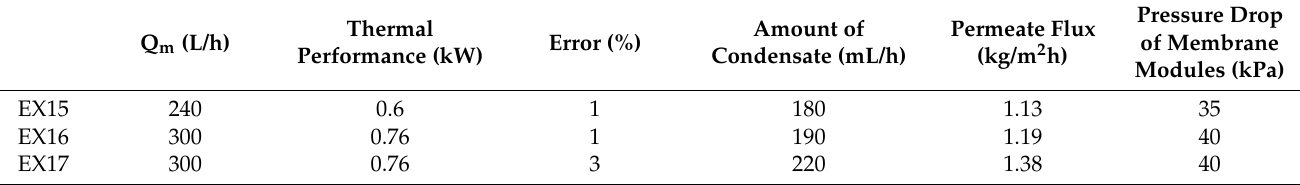
Table 9. Thermal performance, measurement error, condensate amount, permeate flux, and membrane module pressure drop for MM006.